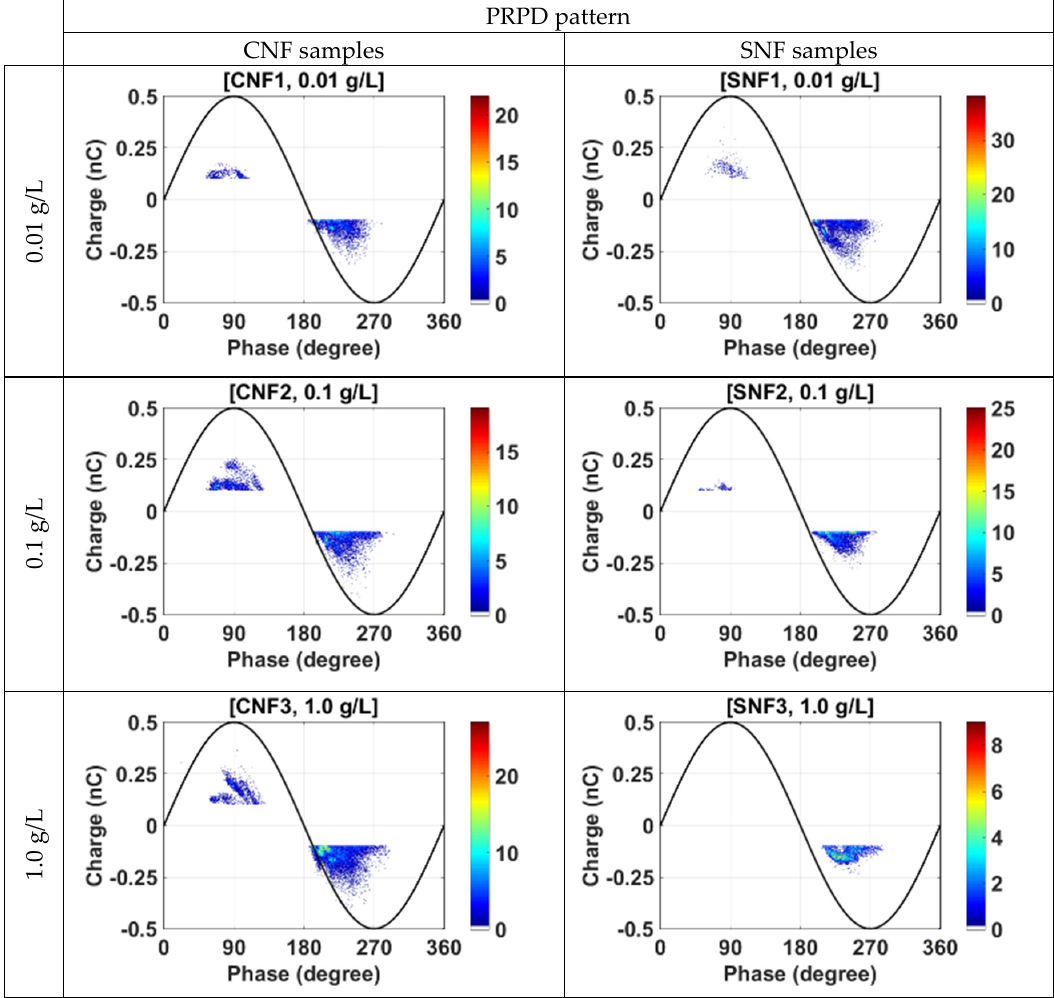
Figure 8. PRPD patterns for nanofluid samples with conductive and semiconductive nanoparticles at 26 kVrms applied voltage in 1500 cycles.